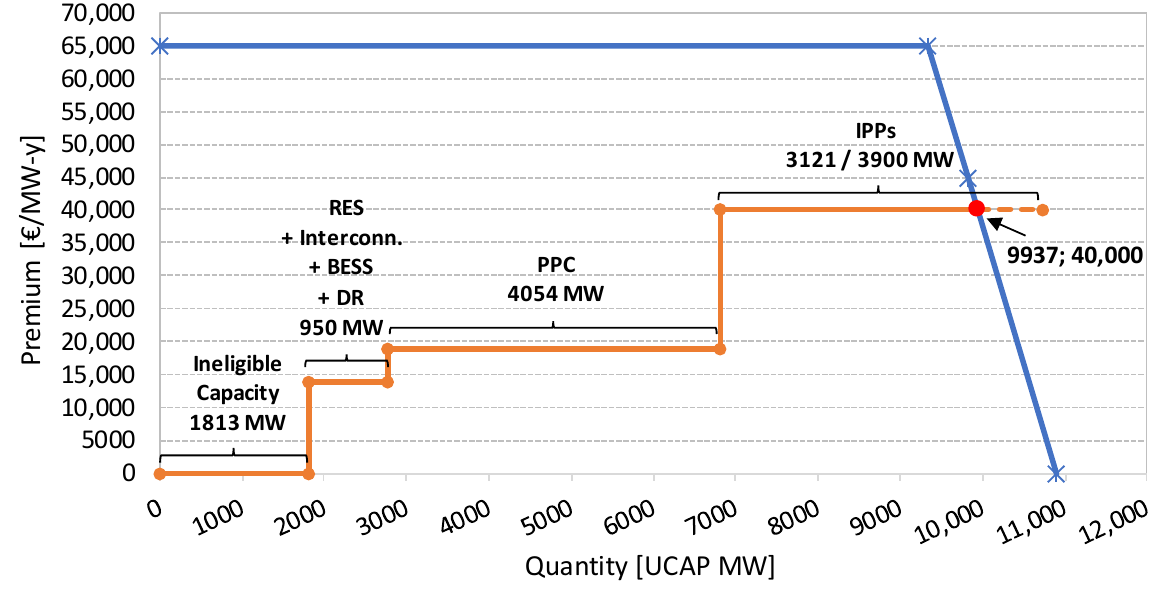
Figure 5. Auction clearing (Scenario 2, Year 2024)–Base strategy.